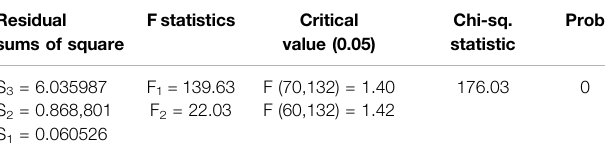
TABLE 3 | Results of covariance analysis and Hausman test. Residual sums of square